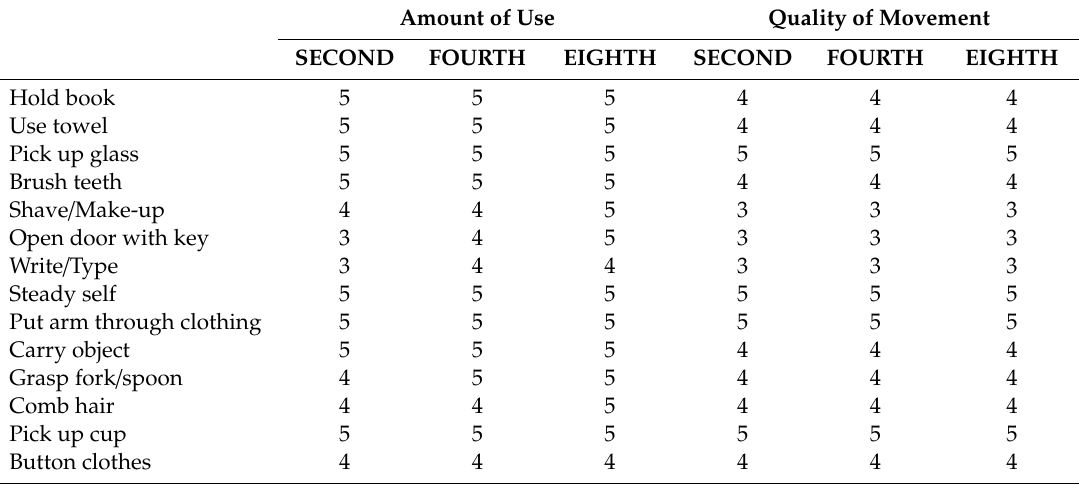
Table A2. Each item of AOU and QOM for Patient